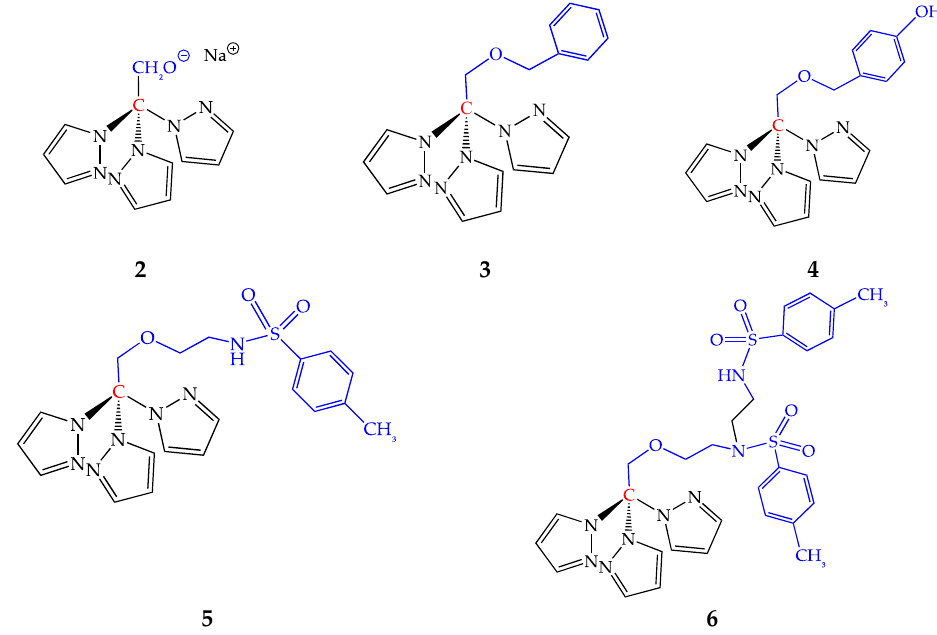
Figure 2. Novel functionalized tris(pyrazolyl)methane type C-scorpionates.